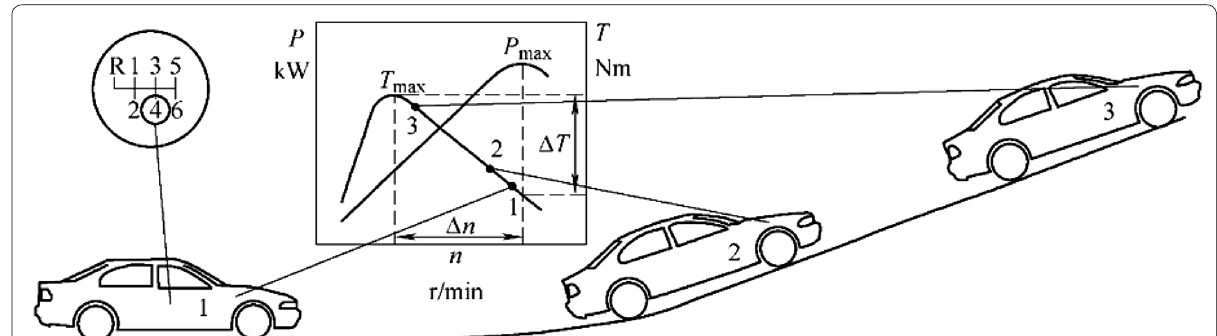
Figure 2 Diagram explaining the principle of the coefficient of flexibility